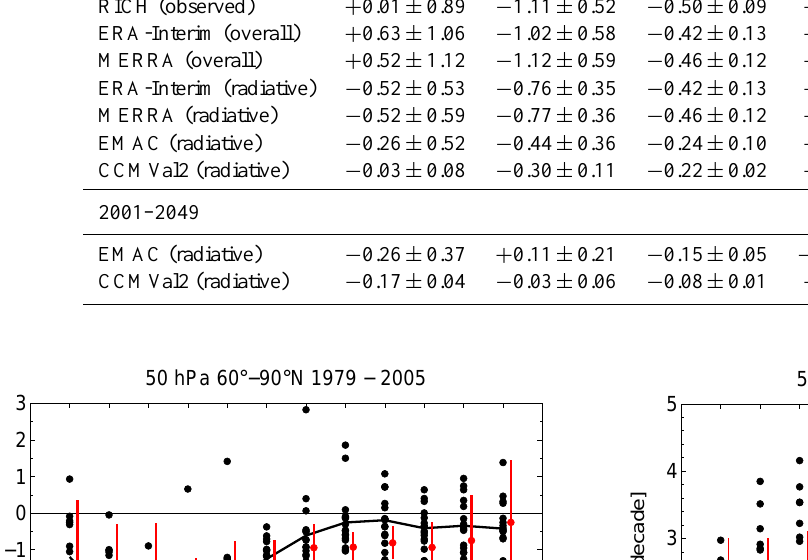
Fig. 4. Arctic ozone trends at 50hPa between 1979 and 2005 from CCMVal2 models (black dots), EMAC model (red dots with error bars) and observed ozone trends from Randel and Wu (2007) (red line with diamonds).